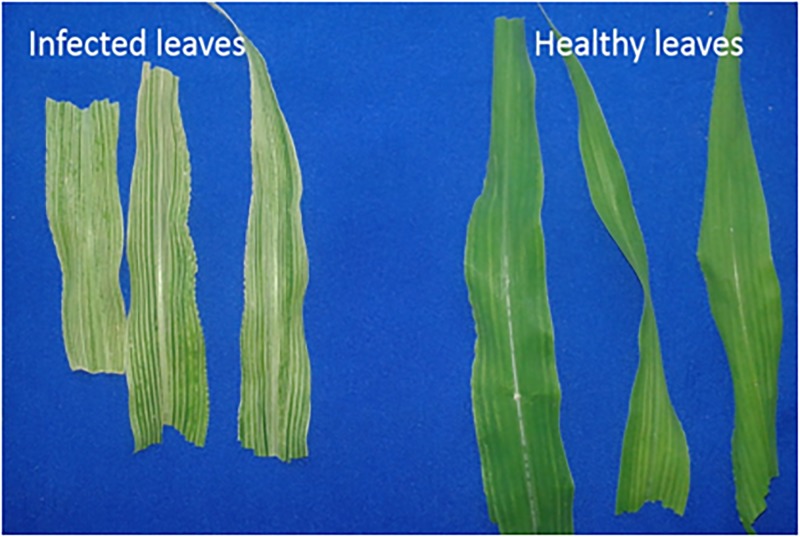
Symptoms on leaves of MIMV-inoculated maize (A) compared with leaves of mock-inoculated plants (B), 15 days after exposure viruliferous (A) or non-viruliferous plant hoppers (B).